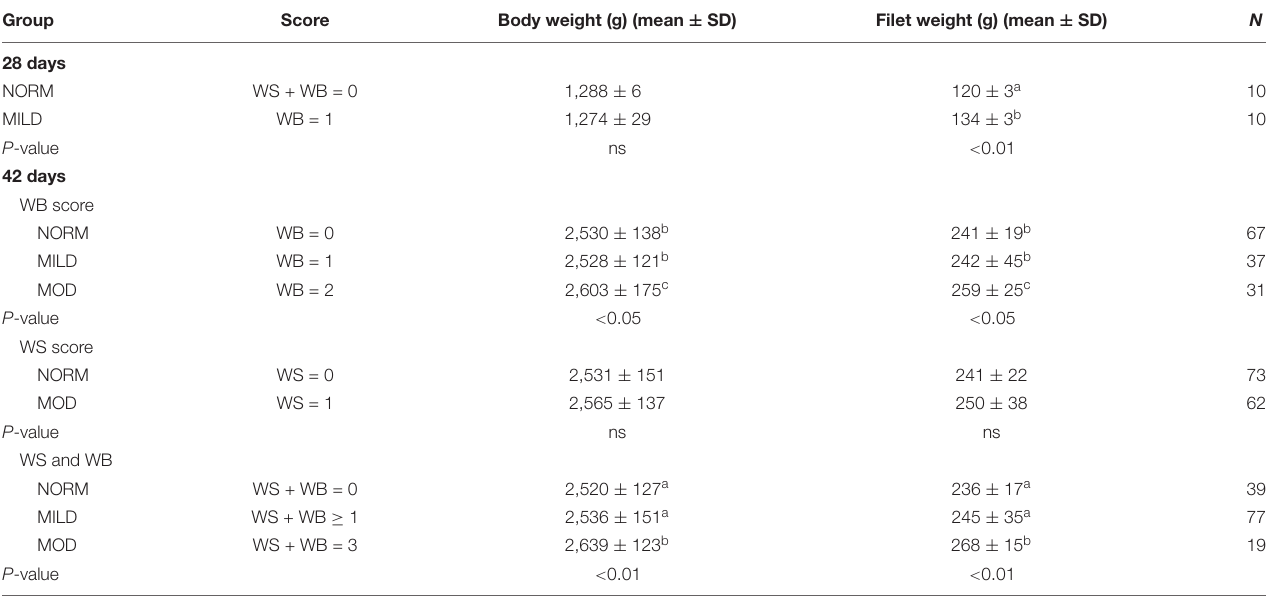
TABLE 2 | Bodyweight, filet weight, and wooden breast and white striping scores at 28 and 42 days of age in flock